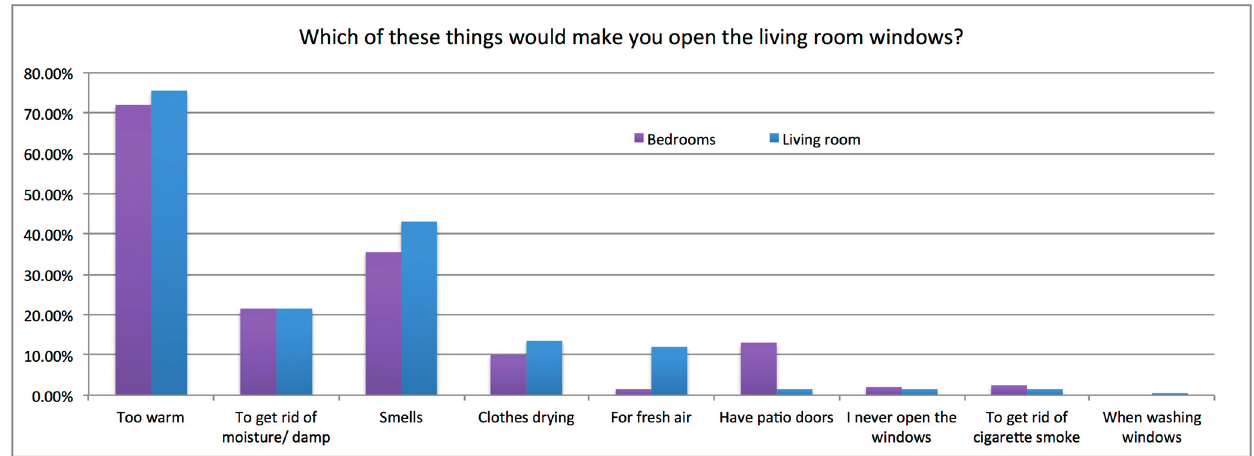
Figure 2. Drivers for window opening, living rooms and